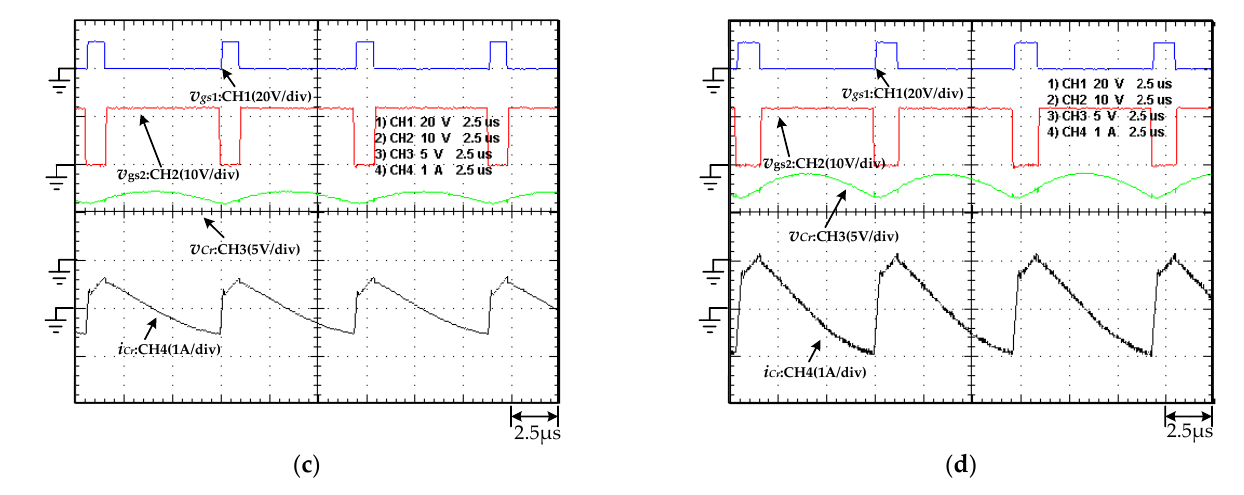
Figure 12. Measured waveforms of v gs 1 , v gs 2 , v Cr , and i Cr at input 48 V under ( a ) 10% load; ( b ) 20% load; ( c ) half load; and ( d ) full load.